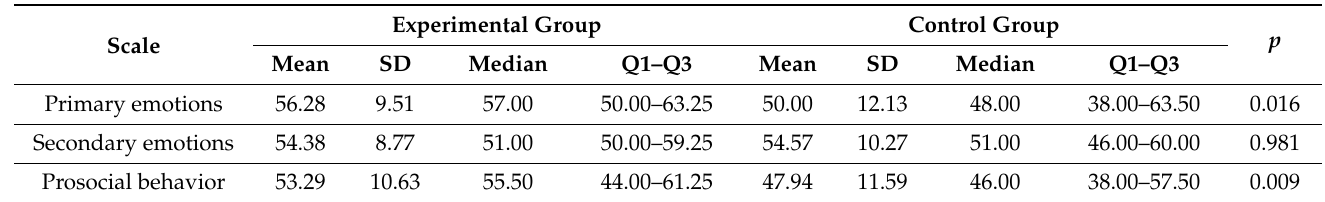
Table 7. Comparison of the EMK 3–6 results of the first assessment in the experimental and control groups.